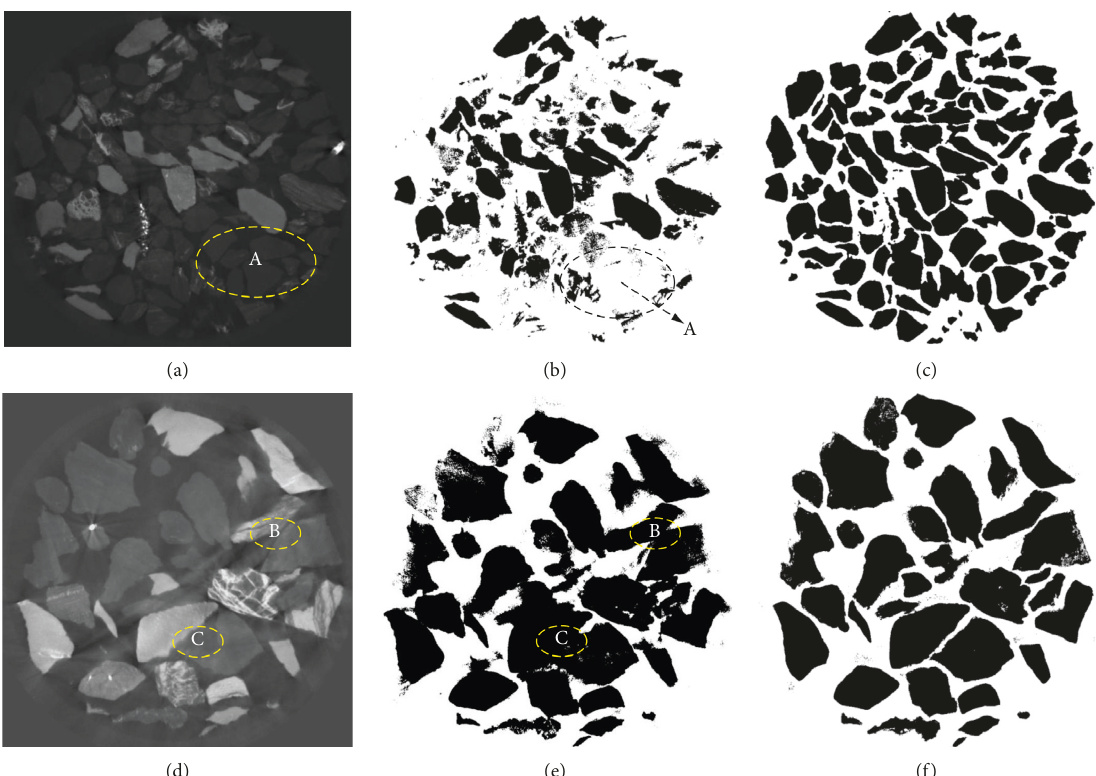
Figure 3: Segmentation results of small-scale CT image and the artificial CT image-based different segmentation algorithms. In this figure, (a) and (d) presents the original small-scale image and artificial image, respectively; (b) and (e) presents the segmentation results based on the conventional threshold algorithm; (c) and (f) presents the improved segmentation results based on the feature-based segmentation algorithm.